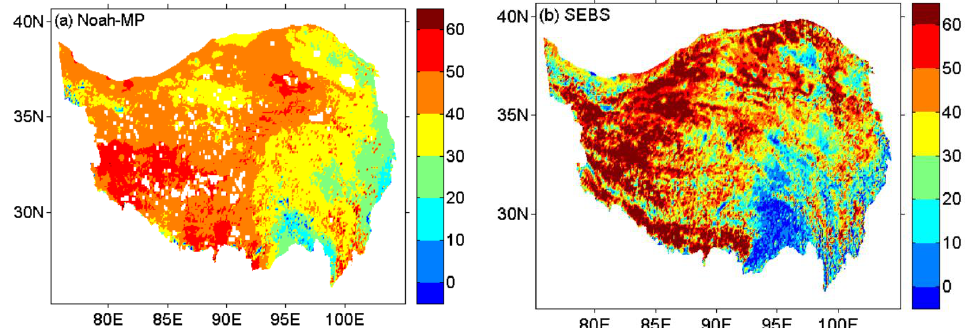
Figure 3. Annual mean SH fluxes (Wm − 2 ) simulated by ( a ) Noah-MP and ( b ) SEBS on the TP during the period 2001 – 2018.